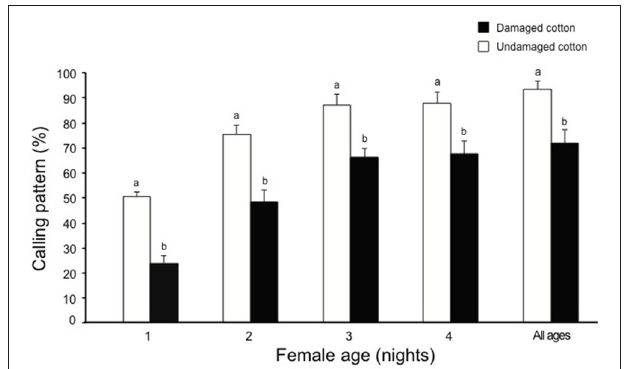
FIGURE 2 | The proportion of S. littoralis females exhibiting calling pattern in the presence of either damaged cotton plants (black bars) or undamaged cotton plants (white bars) for four consecutive nights. Standard errors are represented on each bar. Chi square test was used for statistical analysis. Different letters within the bars of each age show significant effect and the level of significance was selected as P < 0.05, or 0.01 or 0.001.